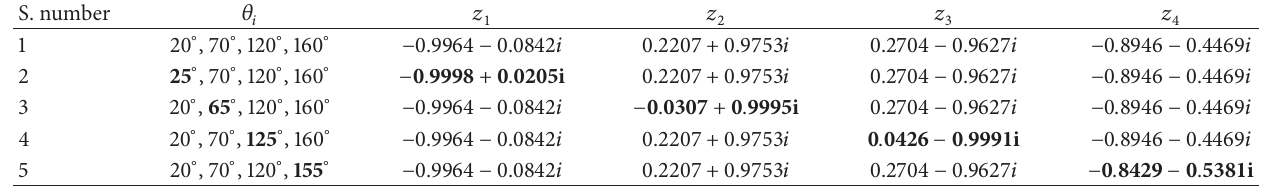
Table 1: Decoupling of weights by proposed algorithm for INS when 𝜃 𝑠 = 95 ∘ , 𝑁 1 = 4 ,𝑁 2 = 5.